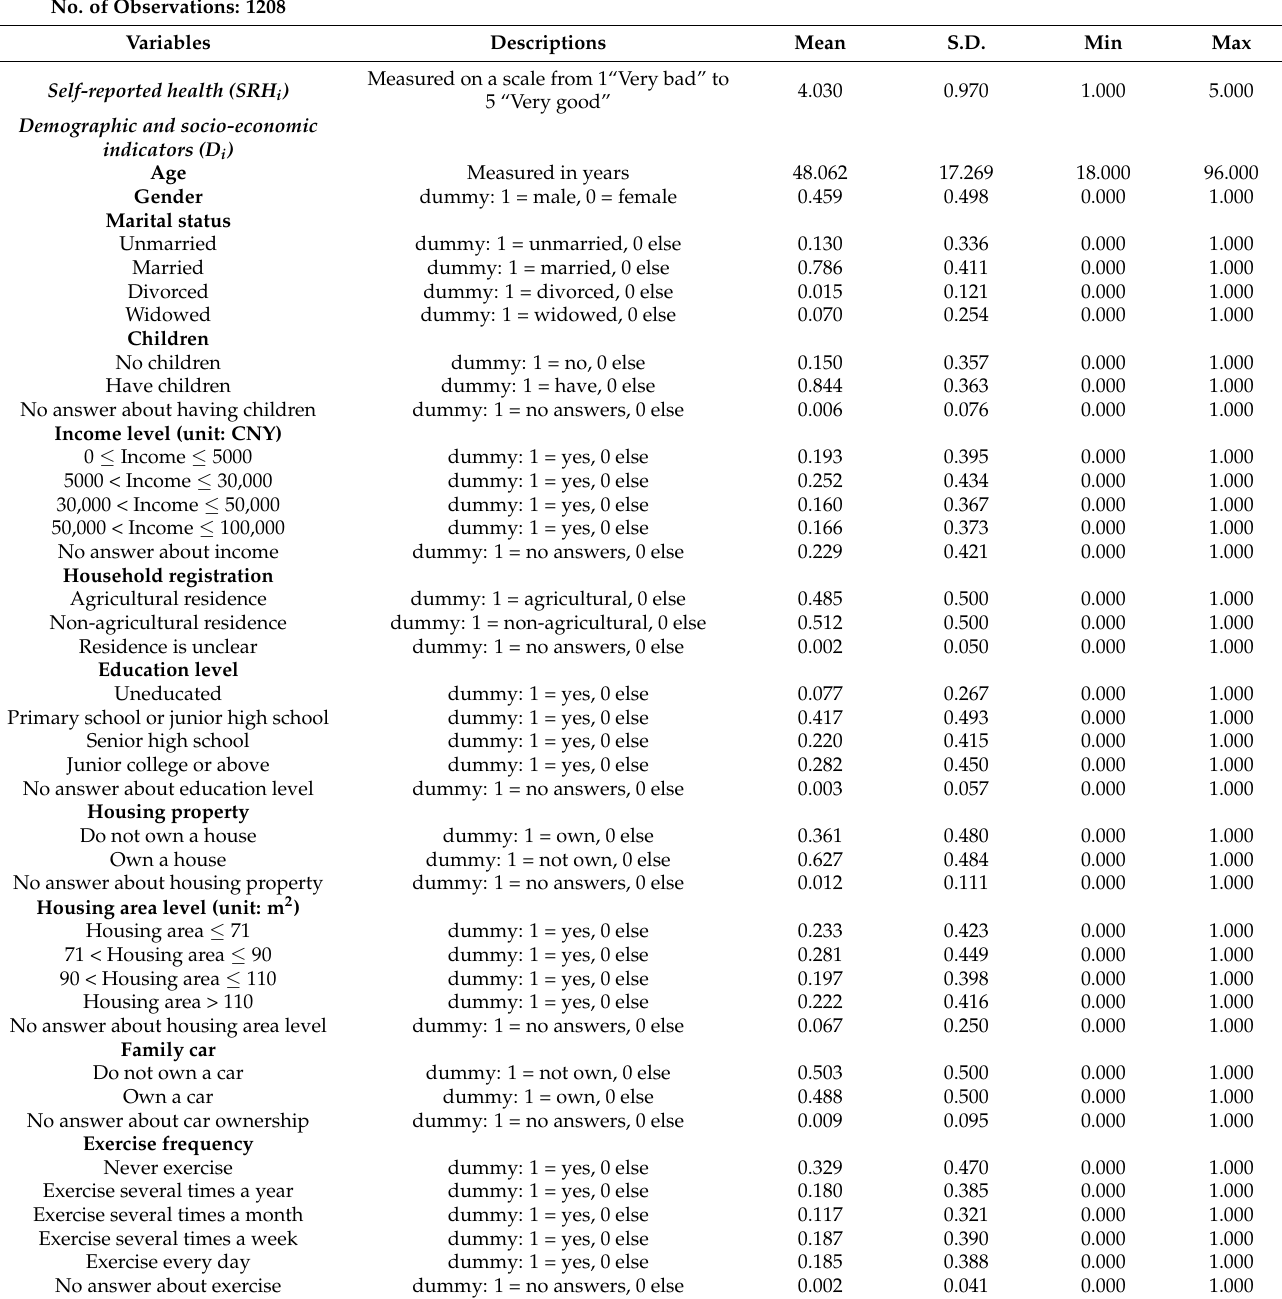
Table 1. Descriptive statistics of the